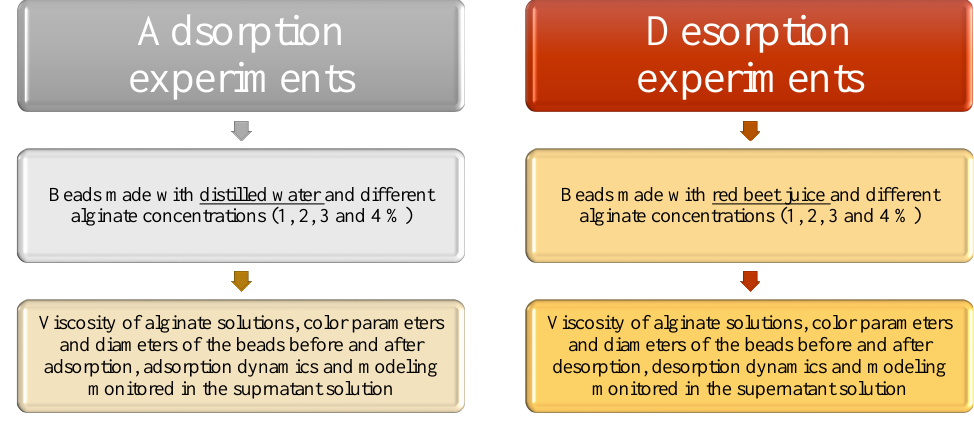
Figure 7. Schematic diagram of the experiment.